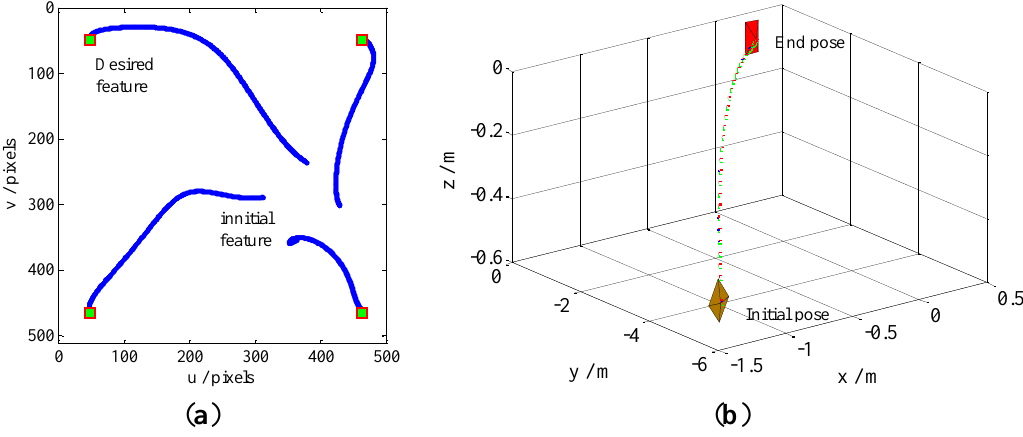
Figure 6. Results obtained by the PBVS method for Case 1. The intrinsic camera parameters are chosen as u